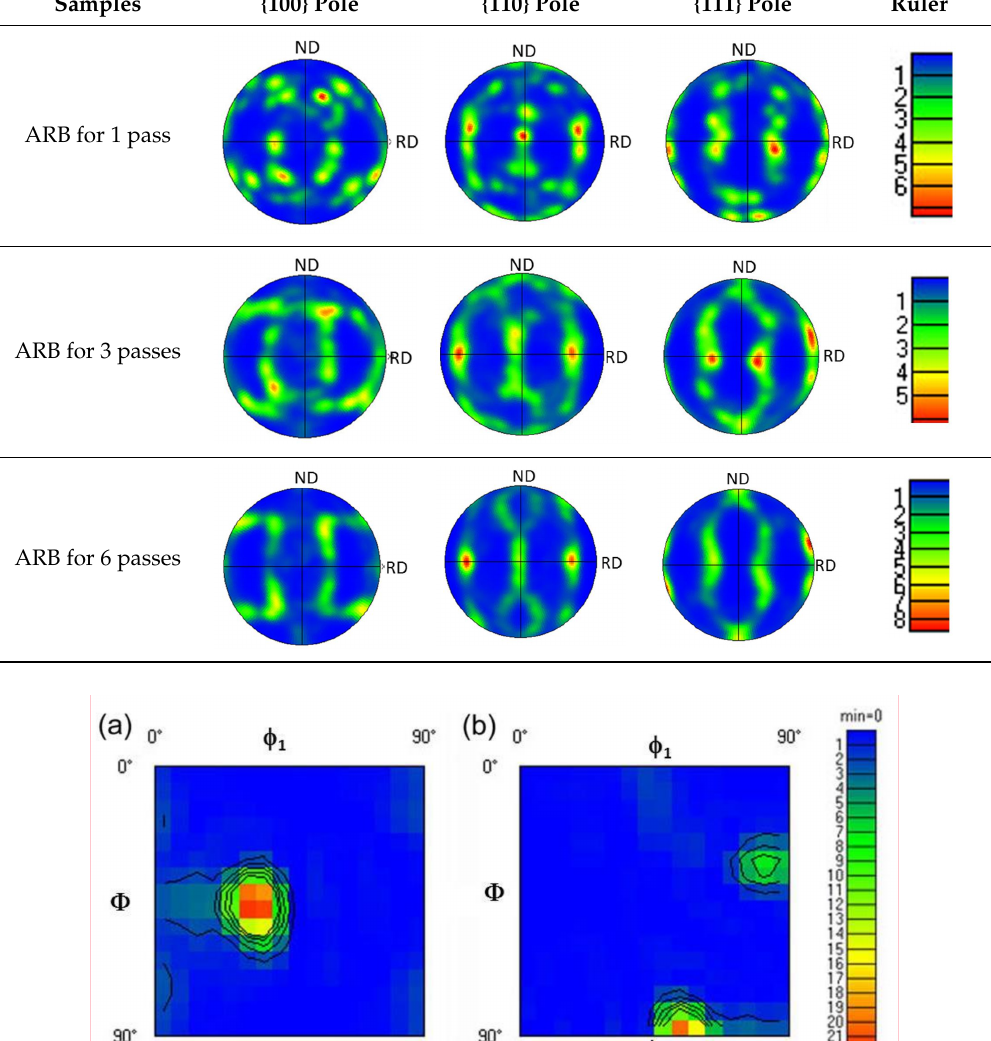
Table 2. List of {100}, {110}, and {111} polar figures of ARB-processed Cu for 1, 3, and 6 passes.